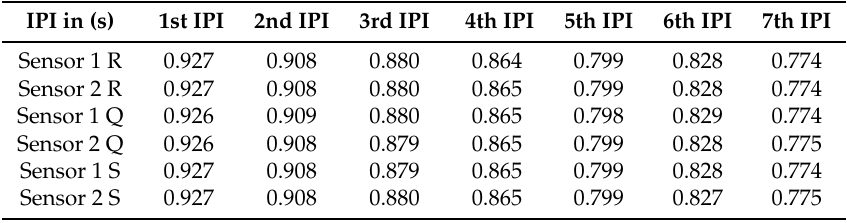
Table 1. Results for two sensors of the Matlab implementation on the PC. IPI in